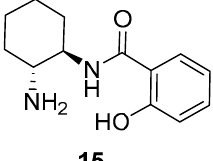
Figure 2. The organocatalyst employed in this study.